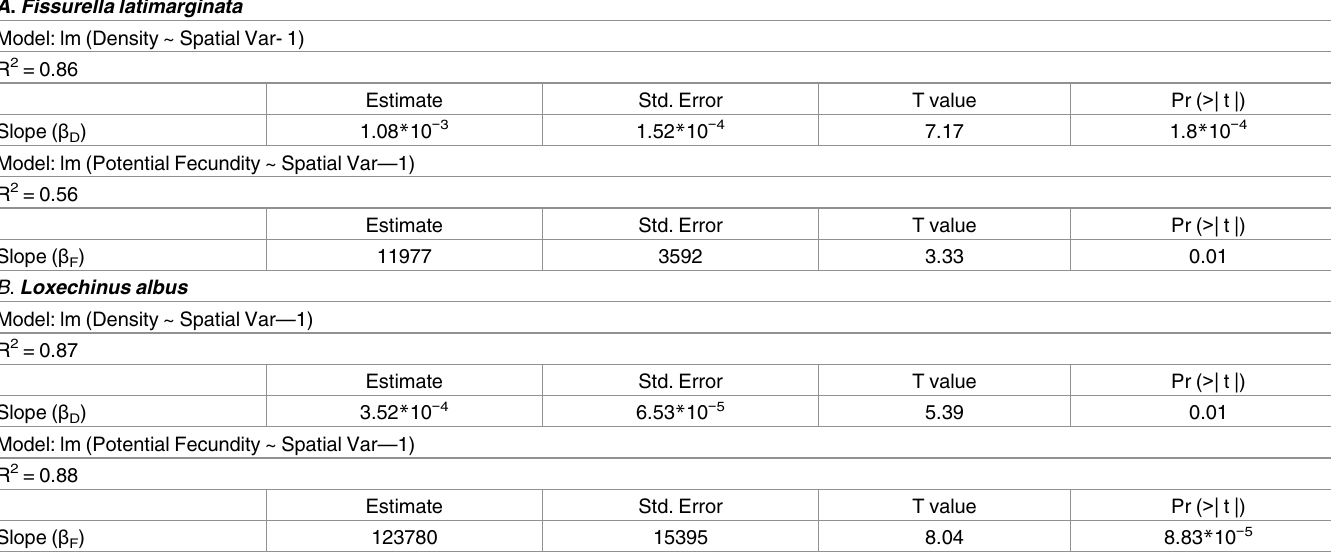
Table 2. Linear regressions. Linearmodels relatingdensity and potentialfecundity,both dependentvariablesand Indicator (Spatial Var; independent vari- able). Linearregressionswere used to obtain the relationship betweenthe indicator(Spatial Var) and the variablesstudied(potentialfecundity and